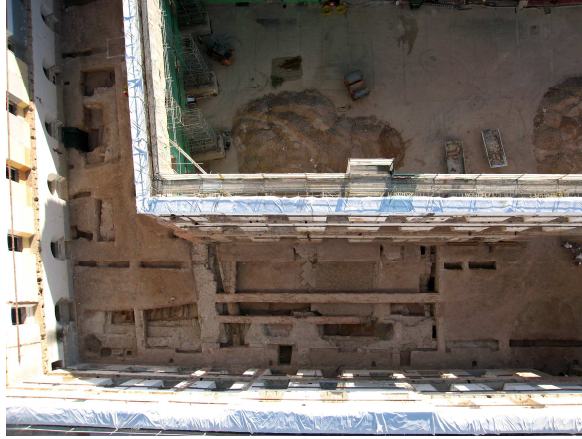
Figure 11. Aerial view of archaeological excavation within the former barracks building with foundations and spaces of the old convent.